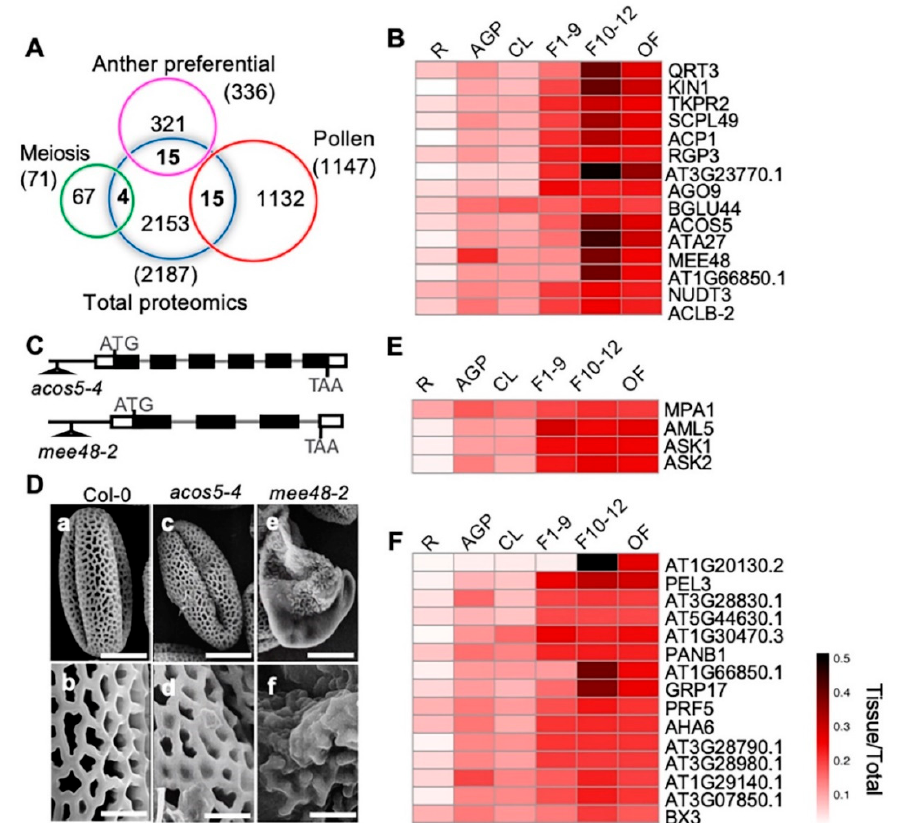
Figure 7. Comparison between our proteome data and published reproductive data and pollen exine phenotypic observation of mutants of two F10–12 preferentially expressed proteins. ( A ) Venn diagram shows comparison among proteomic data from this paper and previously published anther-preferential, meiosis-preferential, and pollen-related gene groups. ( B ) Heatmap shows dynamic expression of the 15 overlapping anther-preferential proteins in the six detected tissues. ( C ) The acos5-4 and the mee48-2 T-DNA insertion mutant alleles. ( D ) Pollen grains from Wild Type (WT) (a, b), acos5-4 (c, d) and mee48-2 (e, f) mutants visualized by a scanning electron microscope. Bars = 10 µ m for a, c, e, 2 µ m for b, d, f. ( E ) Heatmap shows dynamic expression of the four overlapping meiosis-related proteins. ( F ) Heatmap shows expression of the 15 overlapping pollen-related proteins.